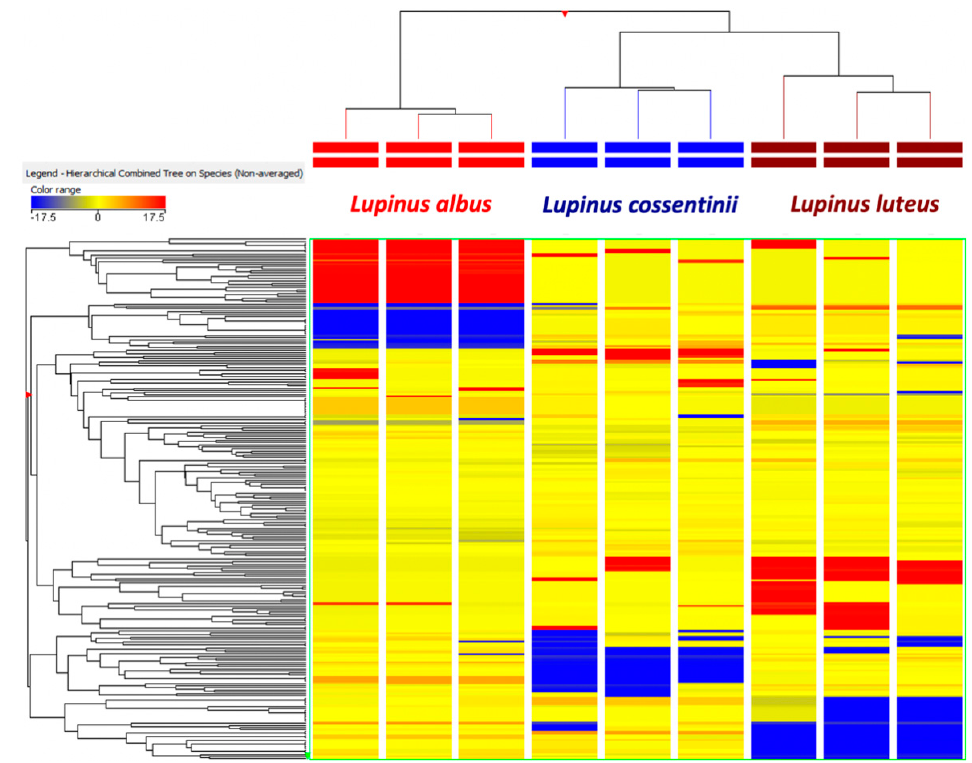
Figure 1. Non-averaged unsupervised hierarchical clustering of the phenolic profiles of Lupinus albus , luteus and cossentinii (similarity: Euclidean; linkage rule: Ward). The compounds’ intensity was used to build up a heat map, on the basis of which the clusters were generated. LA: L. albus; LL: L. luteus; LC: L. cossentinii .